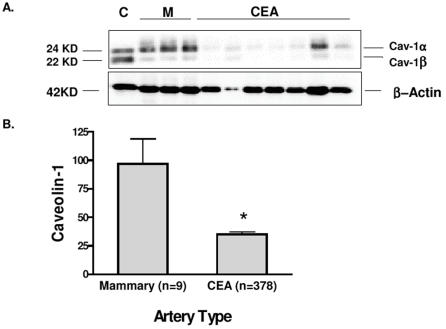
Cav-1 expression pattern in normal and atherosclerotic lesions.A: representative Western Blot. “C” denotes control (pooled sample), “M” denotes mammary arteries, “CEA” denotes carotid plaques. Detection of Cav-1 α and β isoforms (22 and 24 KD; above) and β-actin (42 KD; below) are shown. B: Quantification of Cav-1protein levels in carotid artery vs. control mammary arteries (mean and SE). * p = 0.001. Note that β−actin and Cav-1 expression patterns differ completely, indicating the specificity of Cav-1 down-regulation in CEA samples.